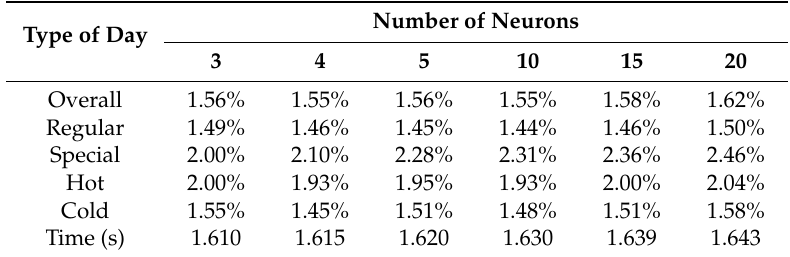
Table 5. Forecasting error (RMSE) and execution time with different number of neurons.